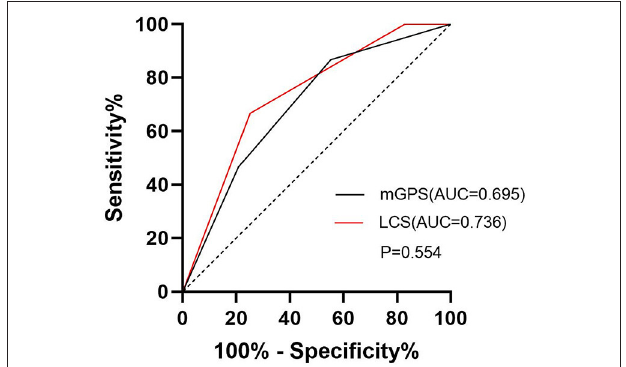
FIGURE 1 | Receiver operating characteristic curves for LCS, and mGPS in the prediction of mortality in patients with acute heart failure. The area under the receiver operating characteristic curve (AUC) for LCS was 0.736, AUC for mGPS was